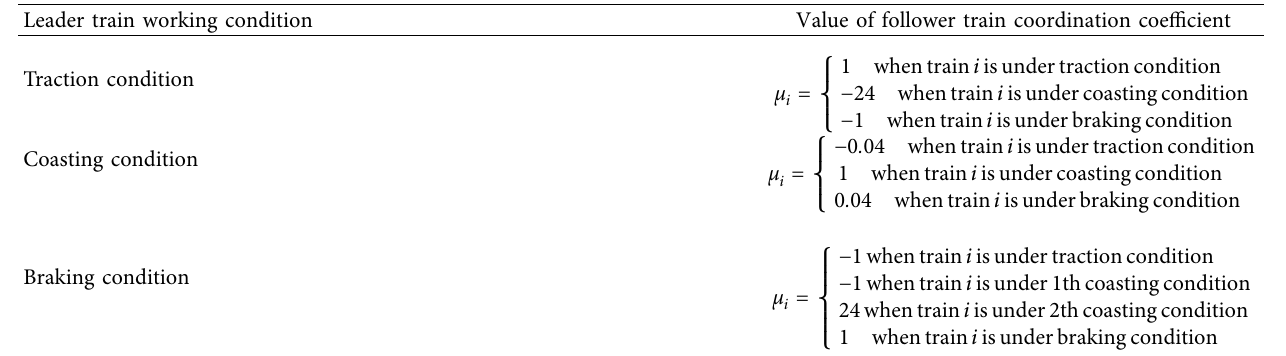
Table 3: Value of coordination